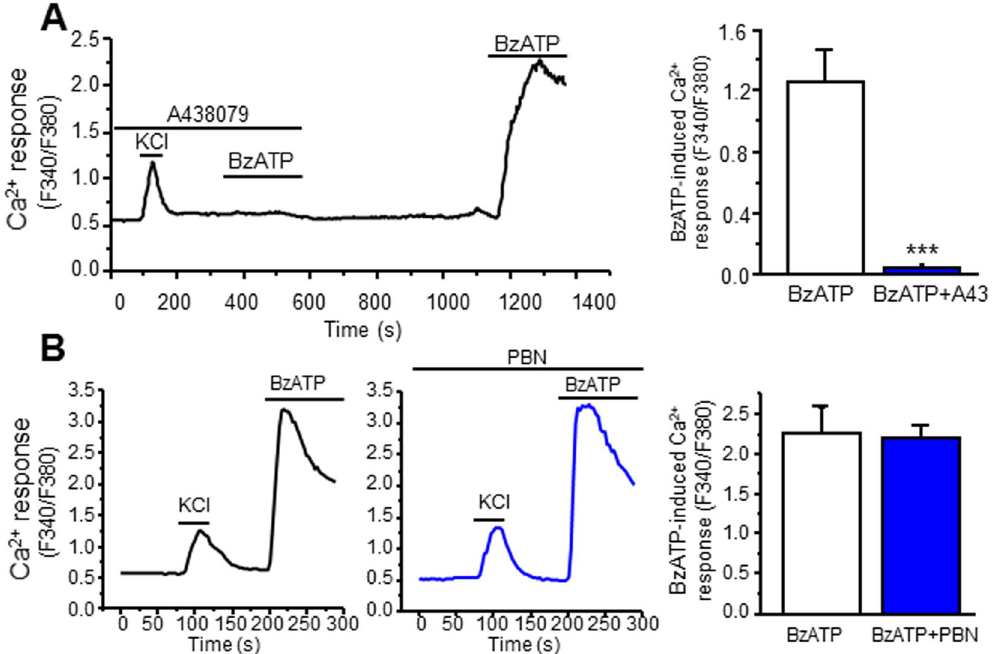
Figure 4. PBN does not affect P2X7R-induced Ca 2 + increases. ( A ) BzATP induces intracellular Ca 2 + increases through P2X7R activation in SCDH neurons. Left panel: Representative Ca 2 + imaging recording of KCl- and BzATP-induced Ca 2 + increases in the presence and absence of A438079. Right panel: Summary of the effects of A438079 on BzATP-induced calcium response. (B) PBN (30 µ M) does not affect P2X7R function. Left panel: Representative Ca 2 + imaging recordings of BzATP-induced Ca 2 + increases in the presence and absence of PBN. Right panel: Summary of the effects of PBN on BzATP-induced calcium response. Values represent mean ± SEM, n = 15–16 neurons. *** P < 0.001 when compared to BzATP 300 µ M by the unpaired Student’s t